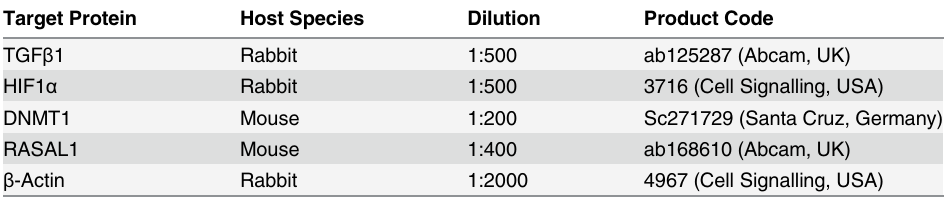
Table 2. Antibodies used for Western